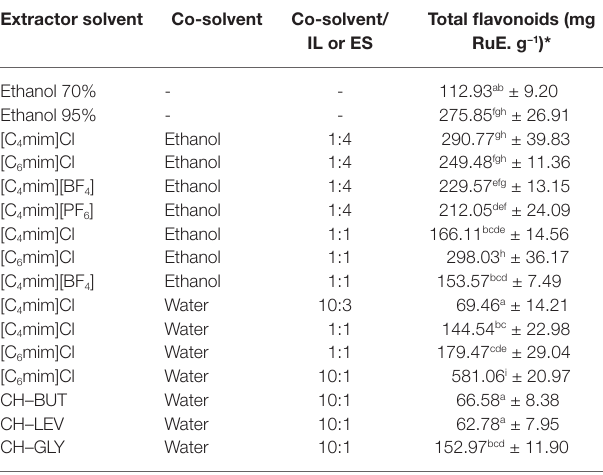
*Values are equal to mean ± standard deviation (SD). Means followed by the same letter in column do not differ by Tukey’s test at 5% significance. Results expressed in mg of rutin per gram of